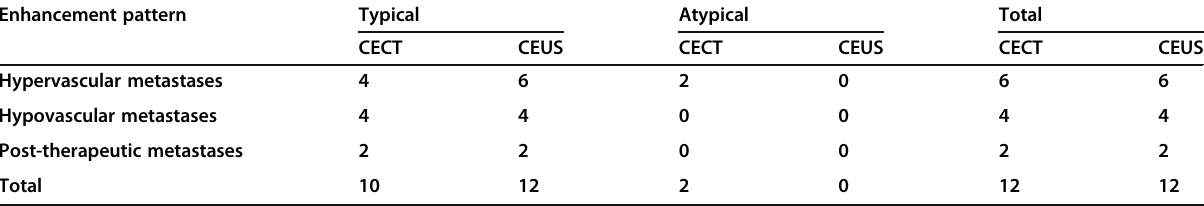
Table 2 CECT and CEUS enhancement patterns showed in patients with hepatic metastases Enhancement pattern Typical Atypical Total CECT CEUS CECT CEUS CECT CEUS Hypervascular metastases 4 Hypovascular metastases 4 Post-therapeutic metastases